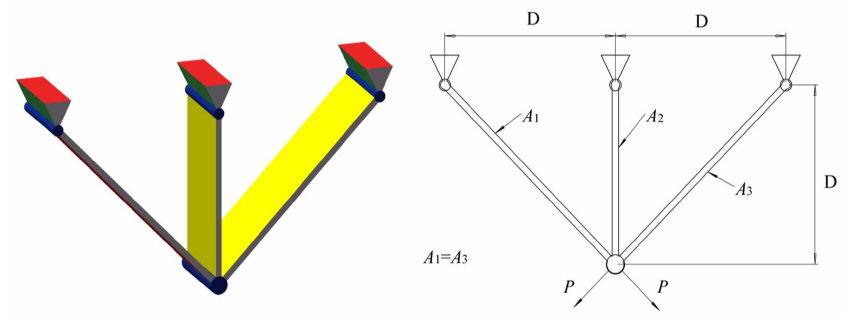
Figure 11. Pressure Vessel Design